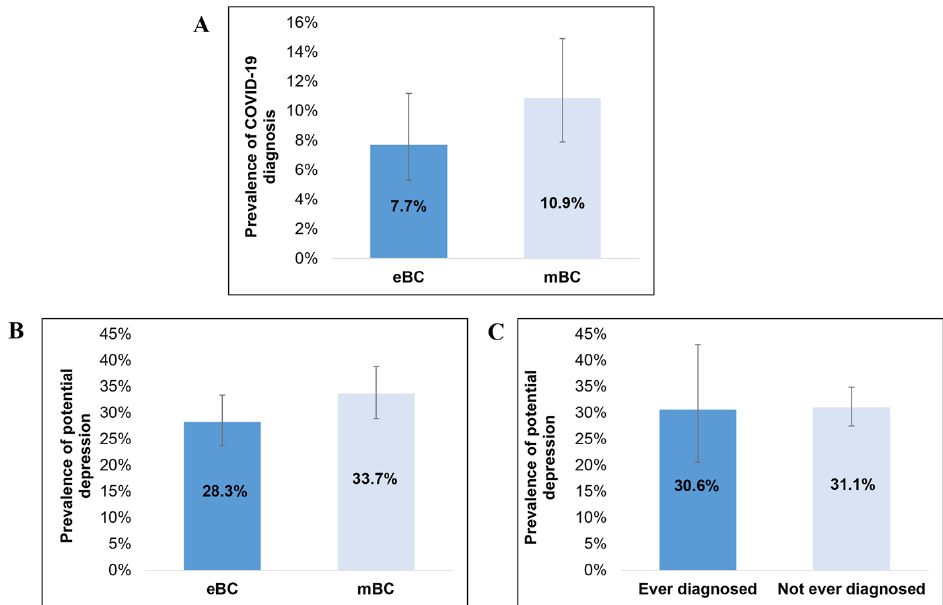
Figure 2. Prevalence of ( A ) COVID-19 diagnosis history by BC type, ( B ) potential depression by BC type, and ( C ) potential depression by COVID-19 diagnosis history. COVID-19, coronavirus disease 2019; eBC: early-stage breast cancer; mBC: metastatic breast cancer. Note: Error bars show 95% confidence intervals. A total of 8 patients were excluded from estimates of COVID-19 diagnosis history prevalence for BC type subgroups and from estimates of potential depression for COVID-19 diagnosis history subgroups ( n = 7 responded “not sure” and n = 1 responded “prefer not to answer” on survey item about COVID-19 diagnosis history).